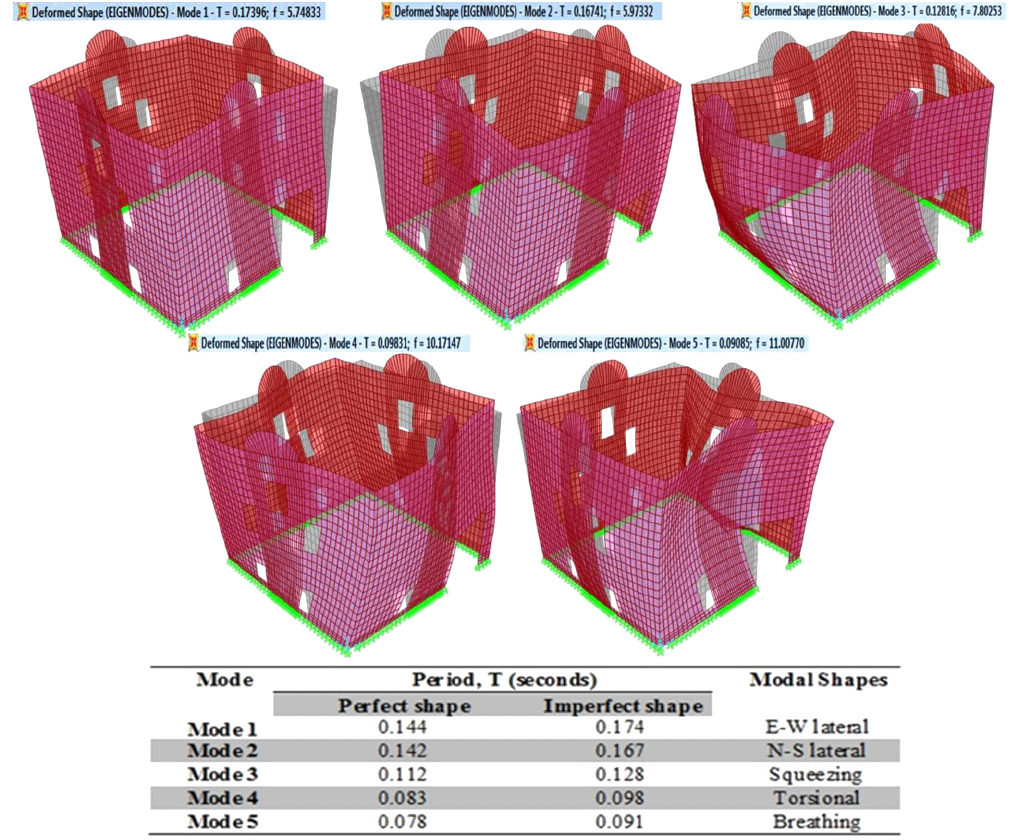
Figure 8. First five modes for as-built and assumed perfect geometry